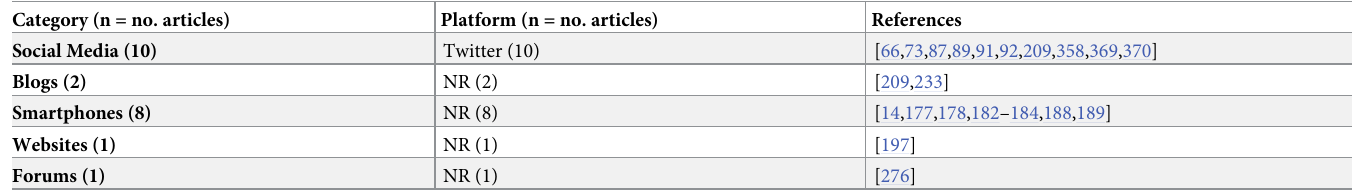
Table 23. Number of articles predicting occupation, with associated platforms and references. Category (n = no.